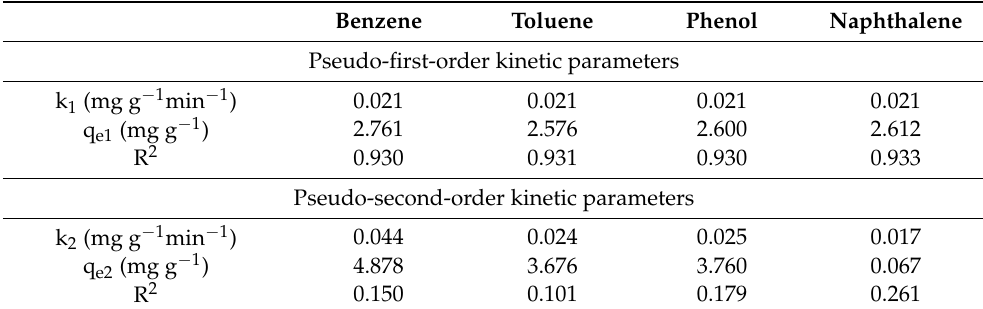
Table 3. Kinetic parameters for adsorption of model HCs on AC. Benzene Toluene Phenol